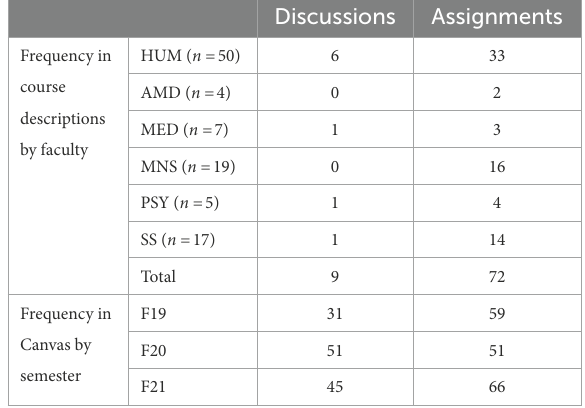
TABLE 10 The frequency of use of the discussions and assignments in Canvas and in course